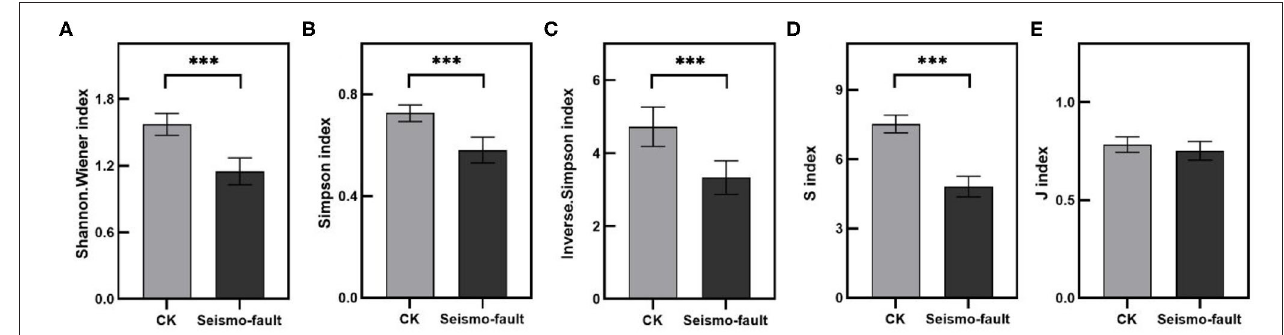
FIGURE 4 | Diversity indices in different seismic regions. (A) Shannon–Wiener index, (B) Simpson index, (C) inverse Simpson index, (D) species richness index, and (E) species evenness index. Vertical bars represent the SE of mean. Asterisks on the SE bars show significant differences between the control (gray bars) and seismo-fault (black bars) (*** p < 0.001).